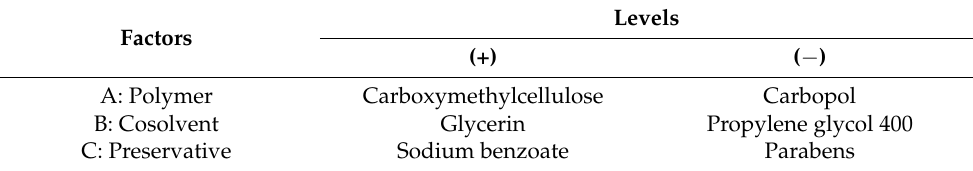
Table 5. Factors studied in the factorial experimental design and their levels.